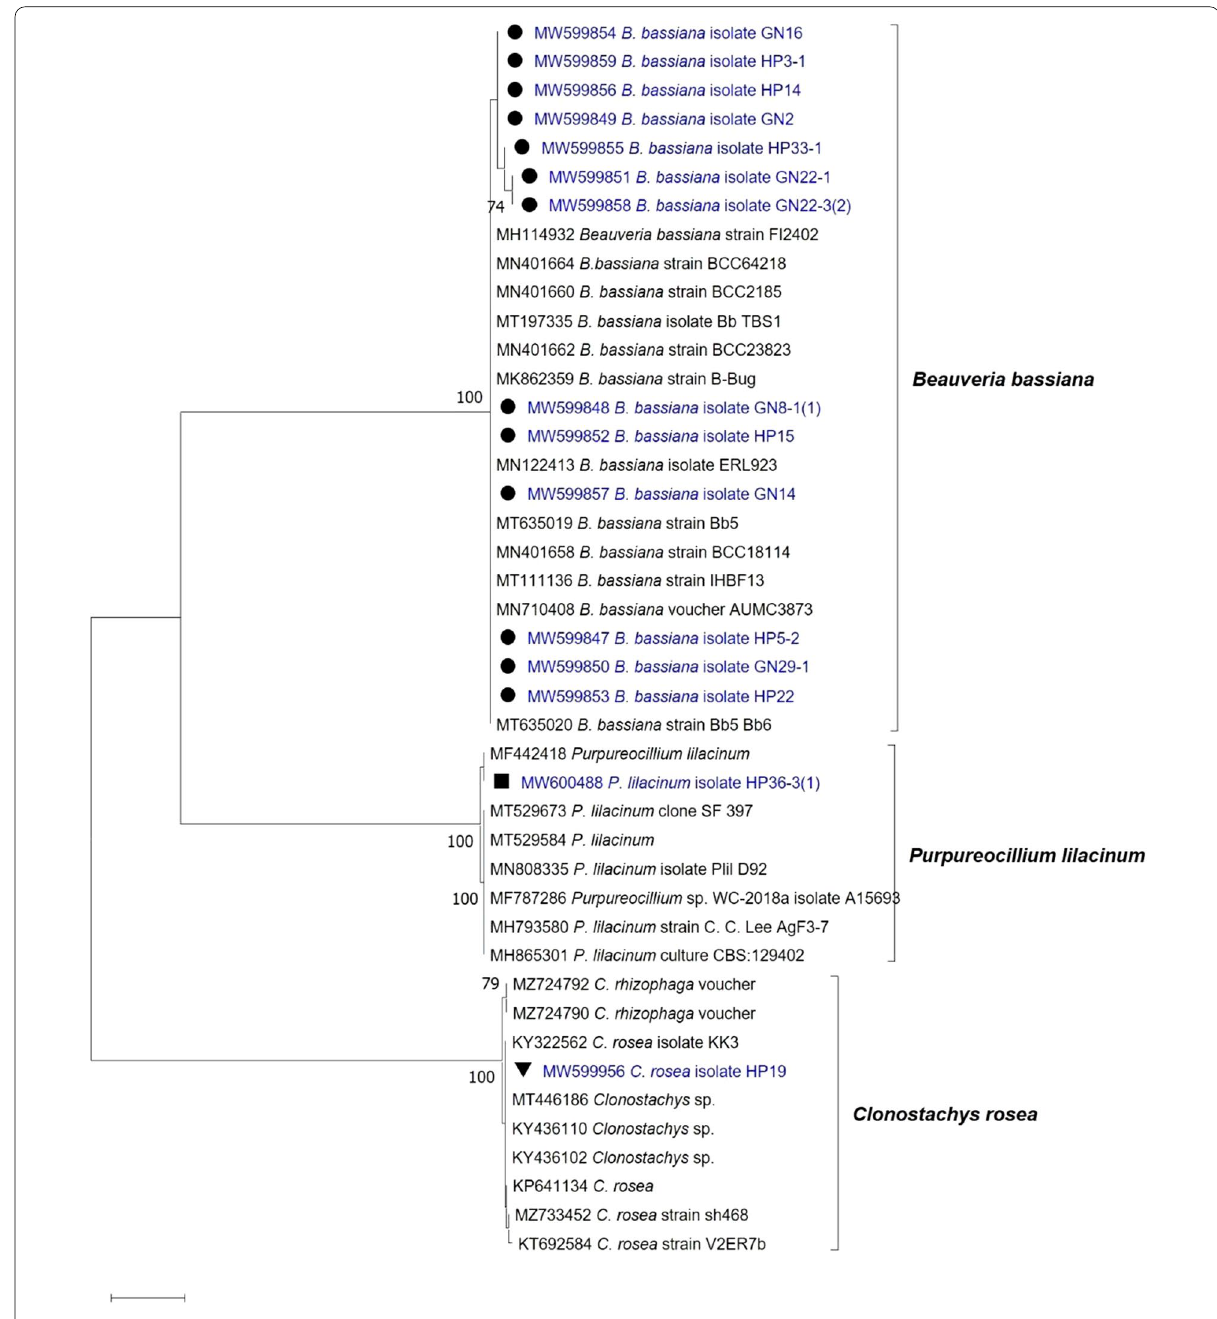
Fig. 1 Phylogenetic tree constructed based on ITS region of the obtained isolates and references using the Neighbor-Joining method. The isolates obtained in this study are shown in blue. Obtained Beauveria bassiana , Purpureocillium lilacinum and Clonostachys rosea isolates are indicated using a black-filled circle, black-filled square, black-filled triangle